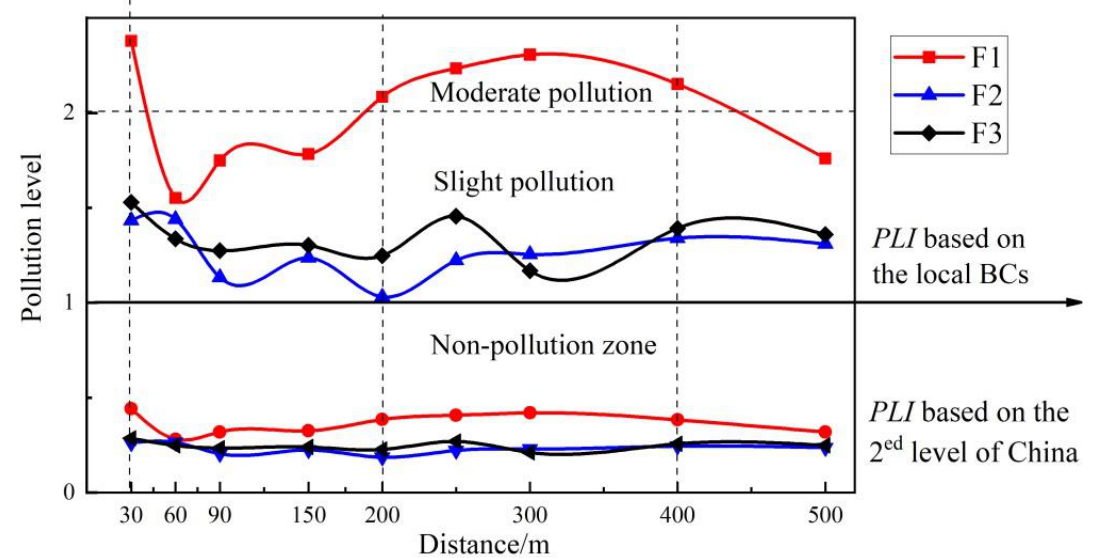
Figure 4. PLI values and heavy metal contamination of dust in sampling transects.